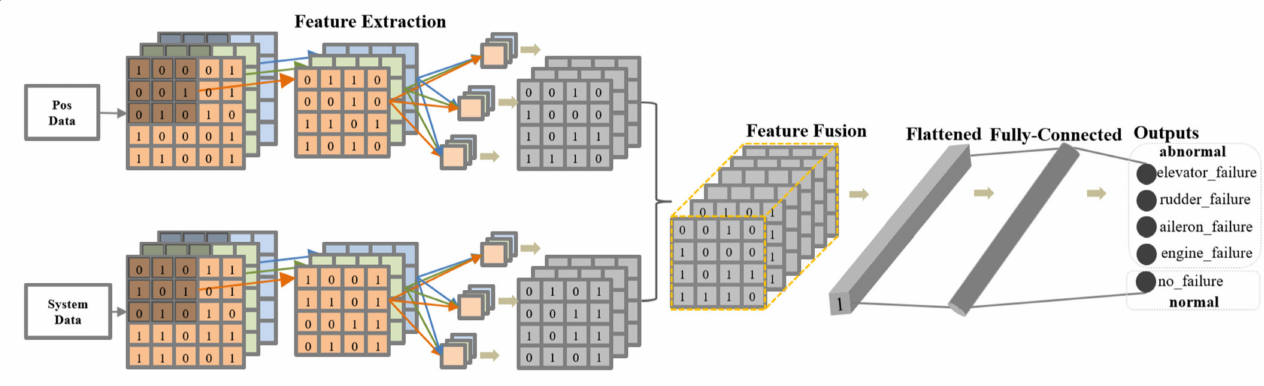
Figure 12. The structure of TS-MSCNN